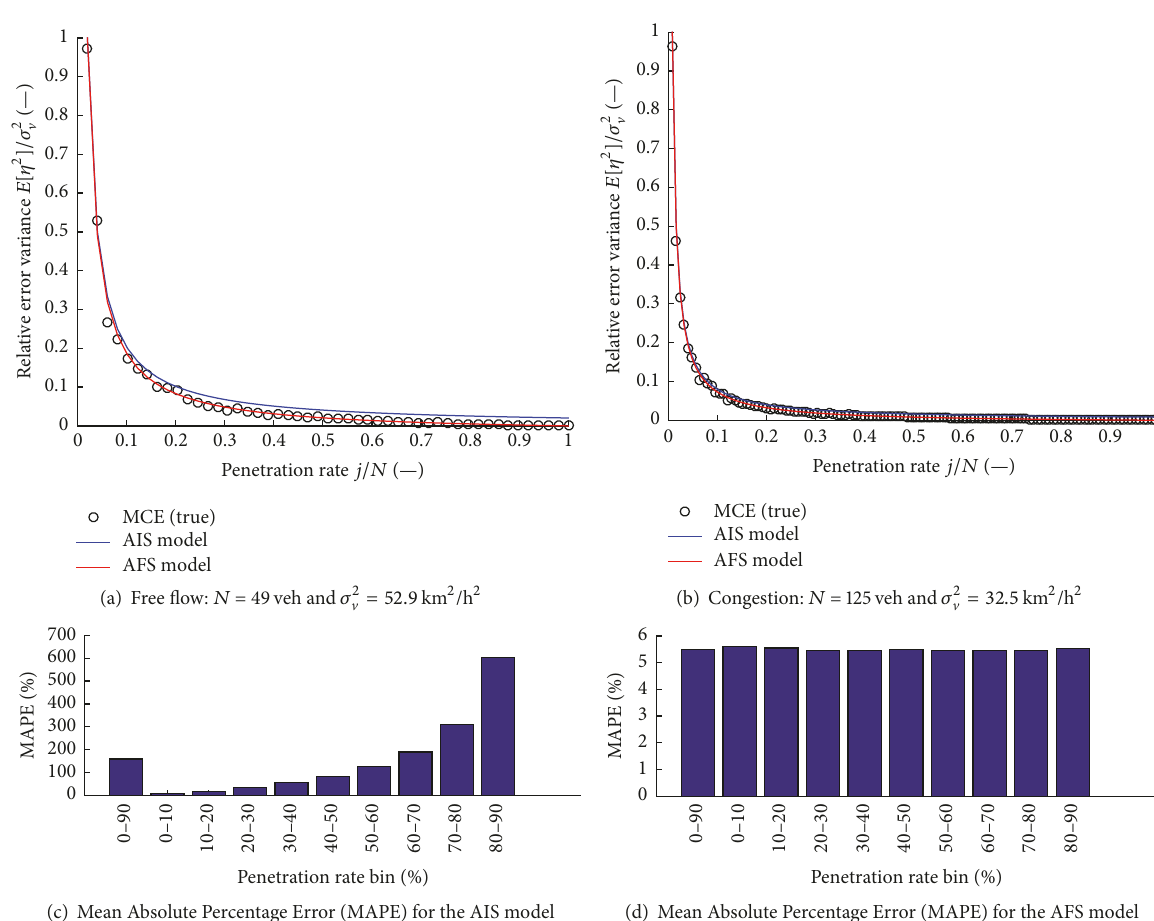
(c) Mean Absolute Percentage Error (MAPE) for the AIS model